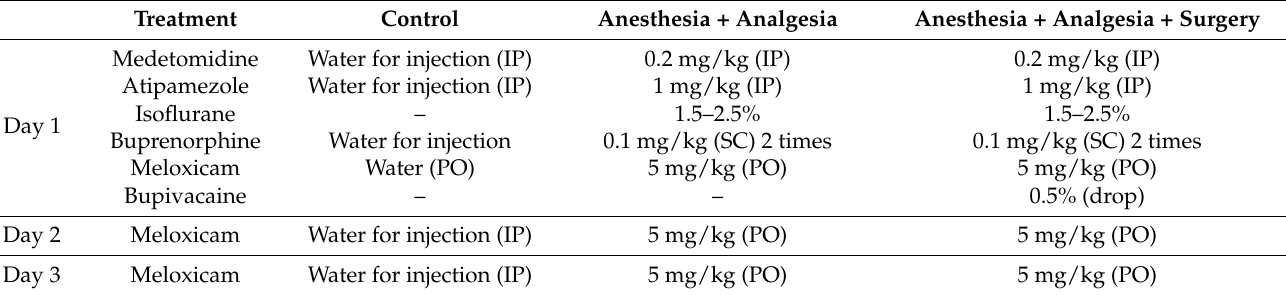
Table 1. Drugs administered to each